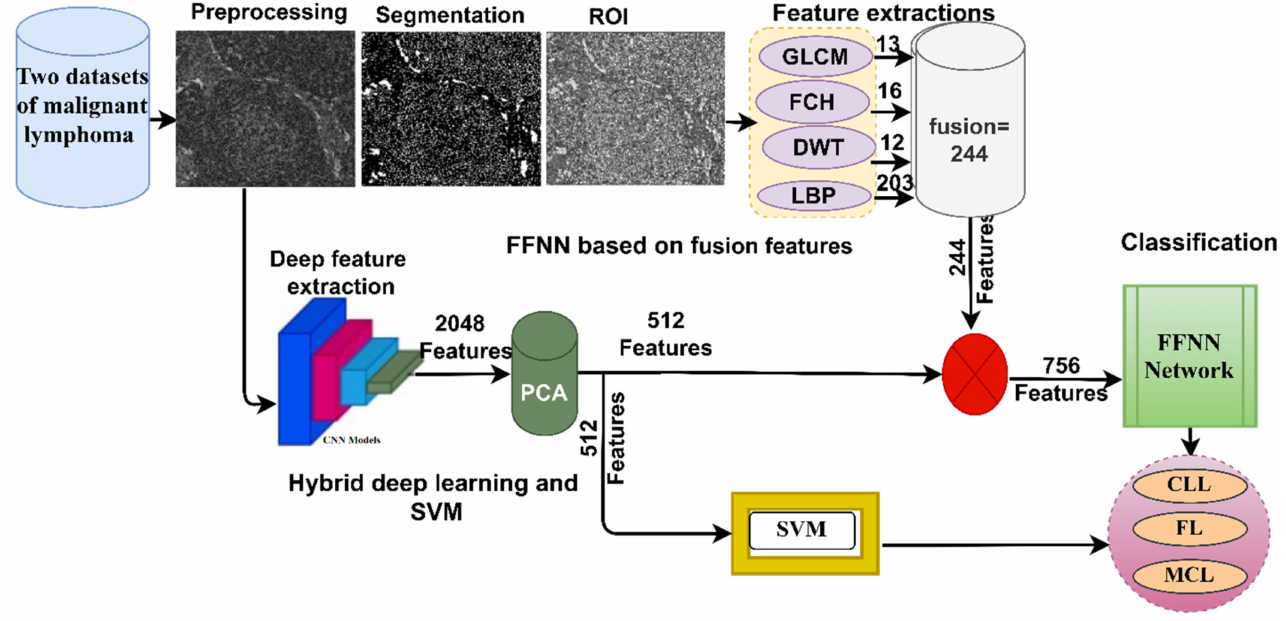
Figure 1. The methodological framework for the early diagnosis of the images of the two lymphoma malignant tumor